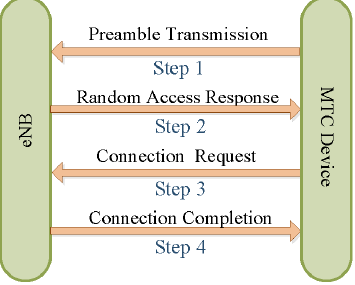
Figure 2. Random access procedures between the M2M device and eNodeB (eNB) in LTE.